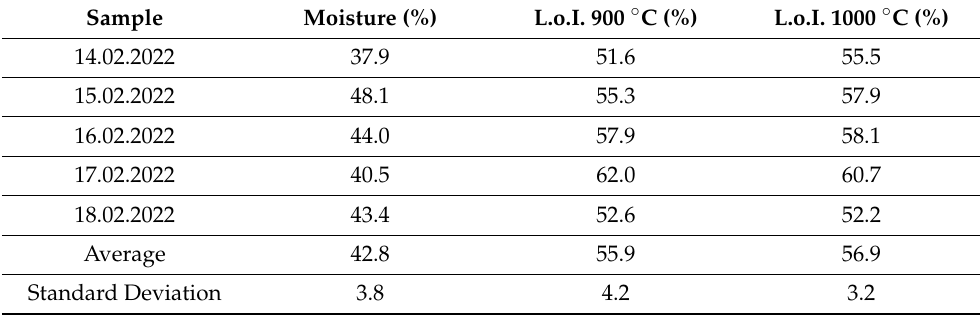
Table 1. Moisture content and loss on ignition of the samples collected on 5 consecutive days.